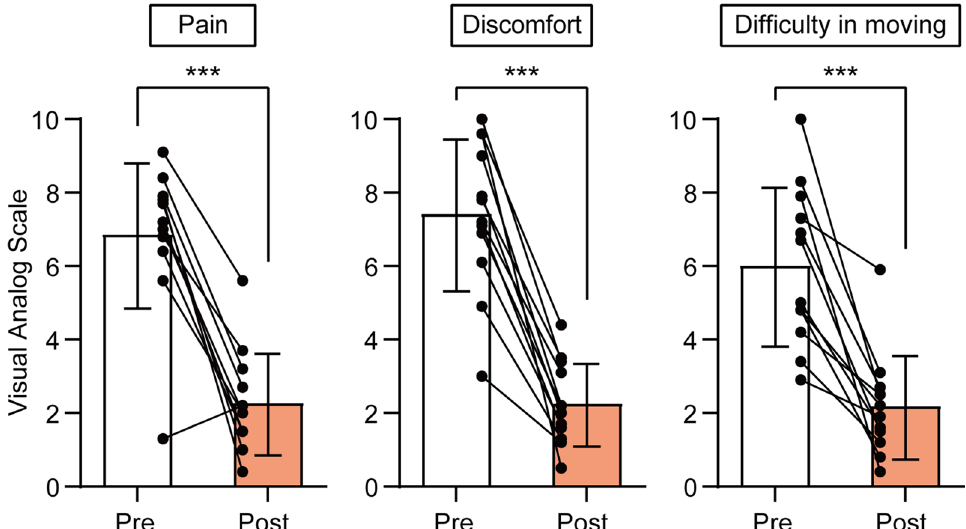
Fig. 2 The effect of the 2-week self-care using microcones on subjective symptoms. Pain, discomfort, and difficulty in moving intensities were evaluated using a visual analog scale. 0 no subjective symptom (pain, discomfort and difficulty moving) and 10 = imaginable. Data obtained before (Pre) and after (Post) the self-care periods were compared using the paired t test. Asterisks indicate a significant difference (*** p < 0.001). Individual closed circles and lines indicate data obtained from each participant. The bar chart and vertical bar indicate the mean and standard deviation. N